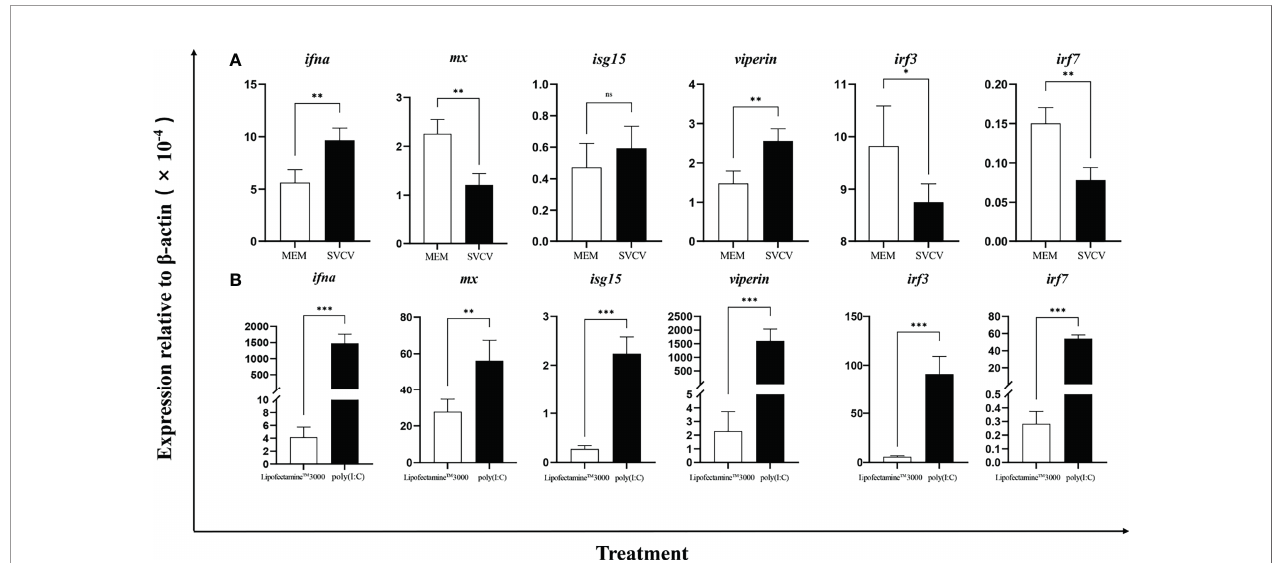
FIGURE 1 | Ifna was induced by SVCV (A) and poly(I:C) (B) . The EPC cells were infected with SVCV (MOI = 1) and transfected with poly(I: C). After 24 h, expression of ifna , mx , isg15 , viperin , irf3 , and irf7 was analyzed by qPCR. Data are shown as mean + SEM (N = 4). *P < 0.05, **P < 0.01, or ***P < 0.001 is considered signi fi cant. ns, no signi fi cant